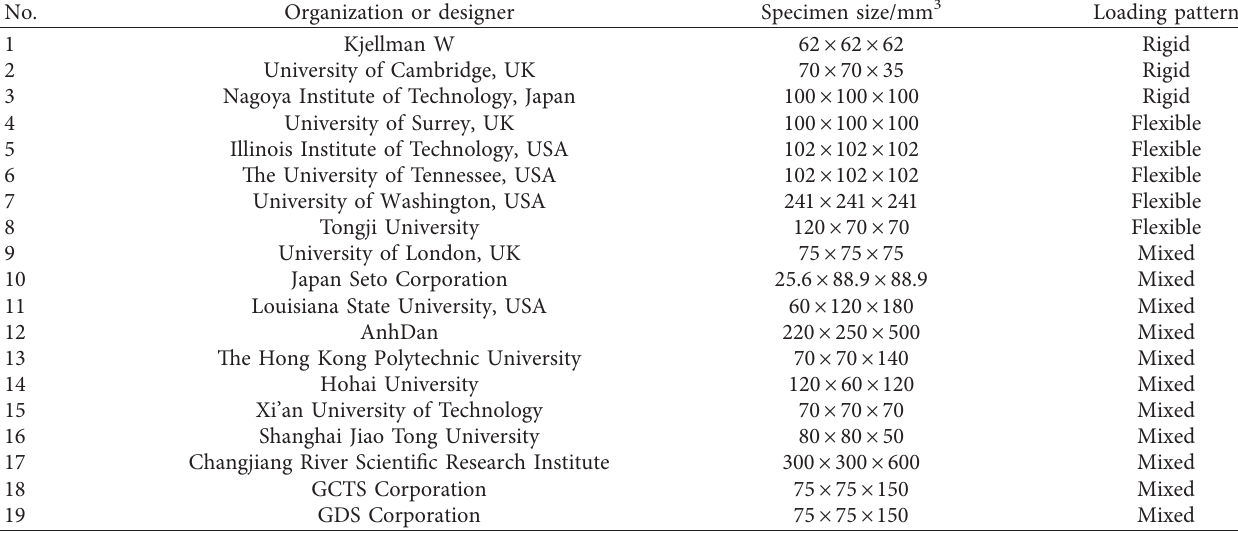
Table 1: Summary of some reported true triaxial apparatuses.